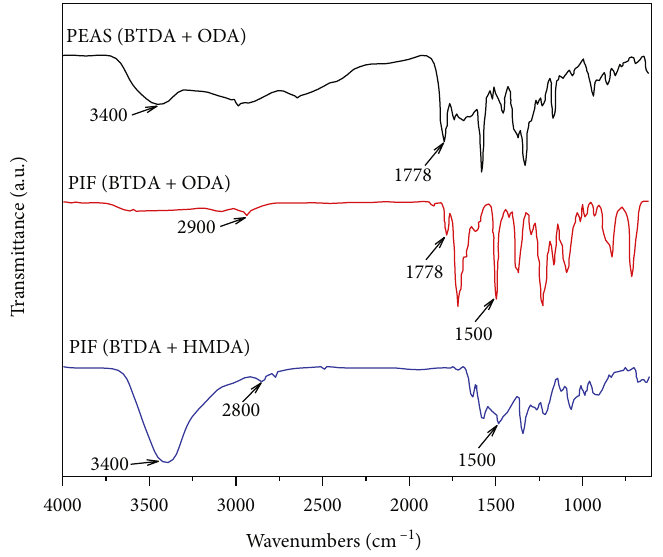
Figure 1: FTIR spectrum of PEAS (BTDA + ODA), PIF(BTDA + ODA) and PIF (BTDA +